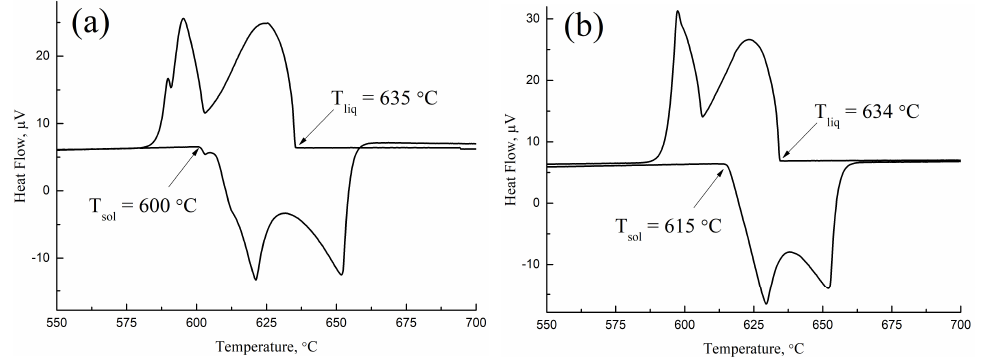
Figure 4. DSC - curves of the Al-Cu-Yb ( a ) and Al-Cu-Gd ( b ) alloys.